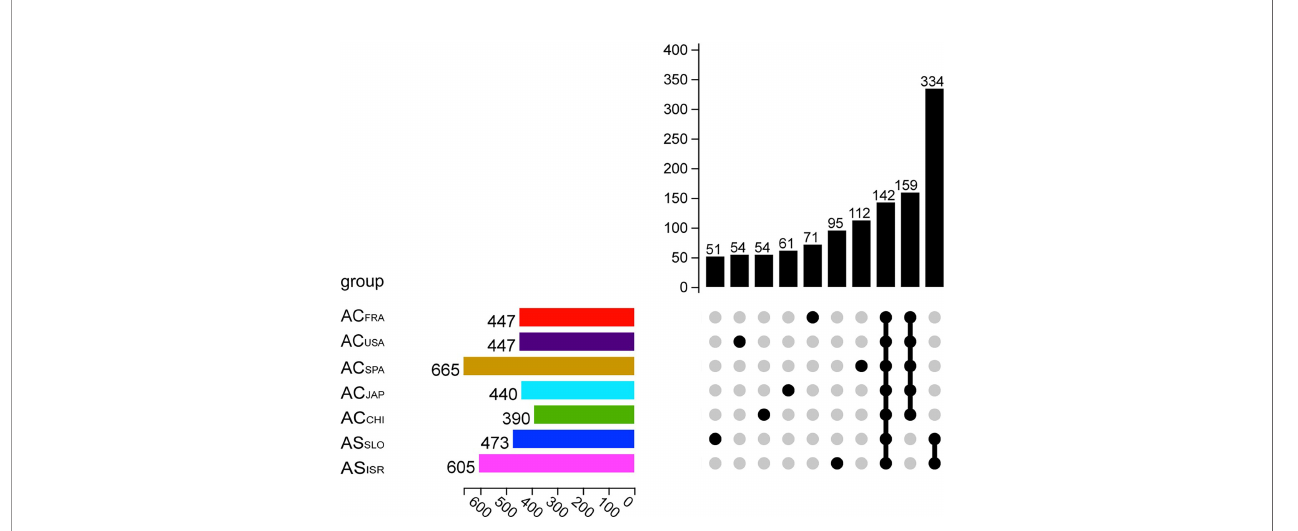
FIGURE 1 | Upset plot showing OTU information of different Aurelia polyp groups. The horizontal column on the left represents the average number of OTUs in the microbiome of each group (n = 5). Each single point in the matrix below indicates that the vertical column above it showd the number of OTUs unique to the corresponding Aurelia polyp group, while the points on the matrix grouped by a line indicate that the vertical column shows the number of OTUs common to those